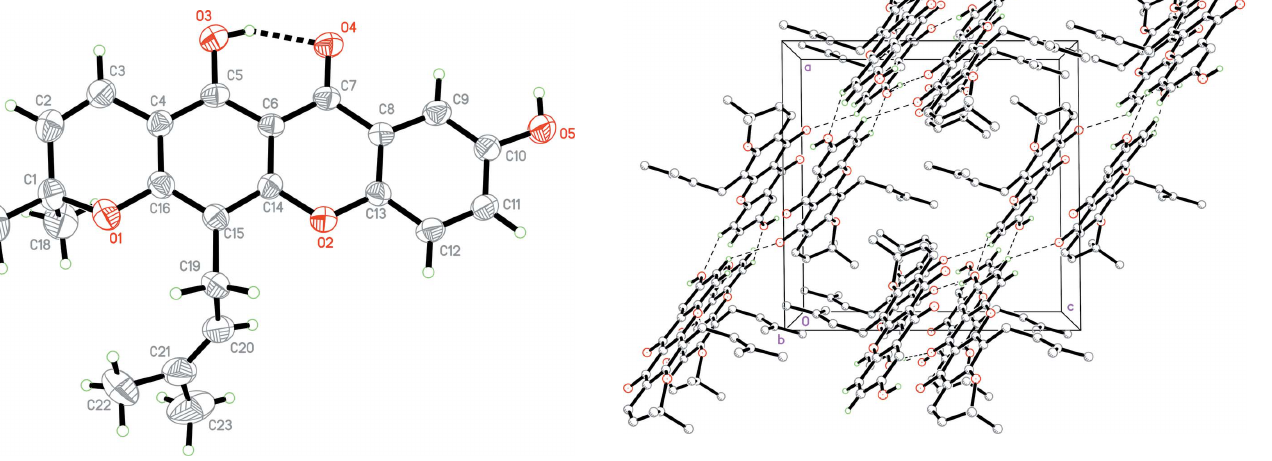
Figure 1 The molecular structure of brasixanthone B showing the atomic labeling. Displacement ellipsoids are drawn at the 30% probability level. The intramolecular hydrogen bond is shown as a dashed